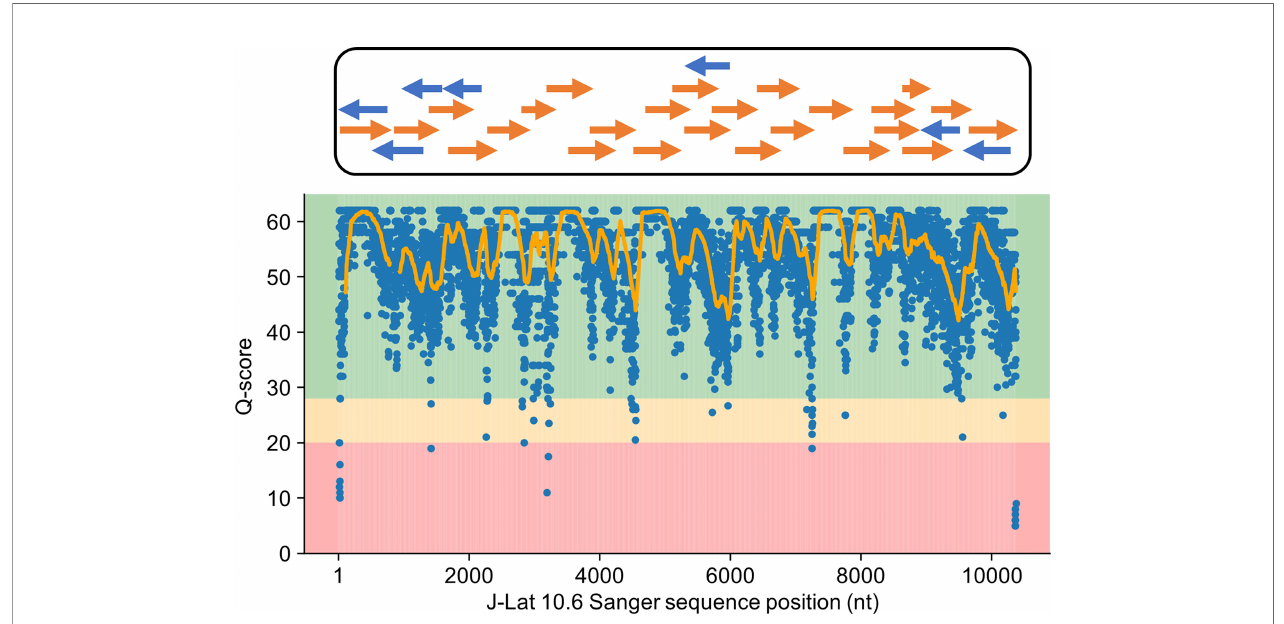
FIGURE 3 | Sanger sequenced J-Lat 10.6 genome served as a high-quality reference genome. Orange and blue arrows represent the forward and reverse stranded Sanger sequences used to construct the reference J-Lat 10.6 genome. The Phred quality scores for overlapping contigs at each position were averaged together into a single positional quality score and plotted along with a line corresponding to a 100-bp rolling average. Positional Phred scores largely reside in the 40 – 60 range, corresponding to accuracies between 99.99 and 99.9999%. Given this, the J-Lat 10.6 genome can serve as a high-quality-reference to evaluate the performance of and train HIV-Quasipore